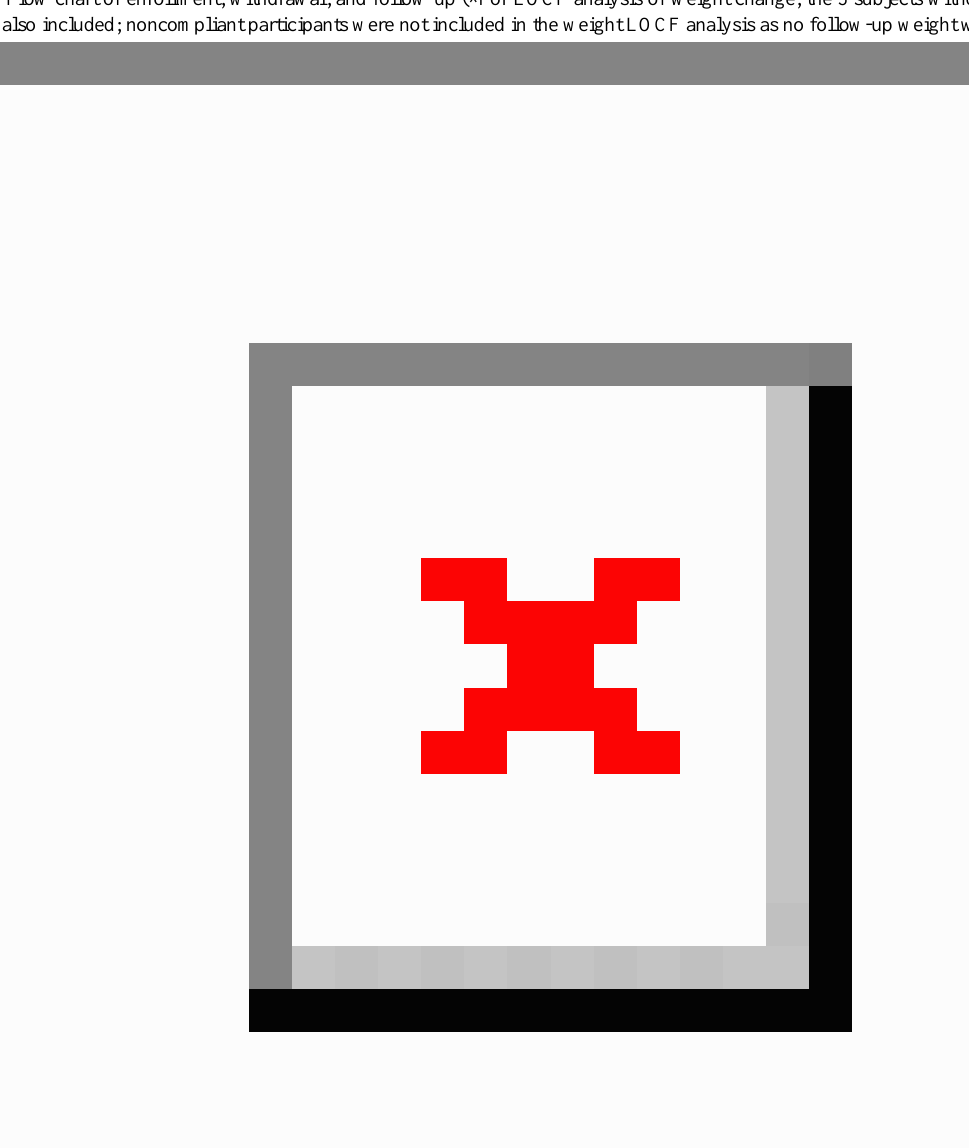
Figure 1. Flow chart of enrollment, withdrawal, and follow-up (*For LOCF analysis of weight change, the 5 subjects withdrawing after the